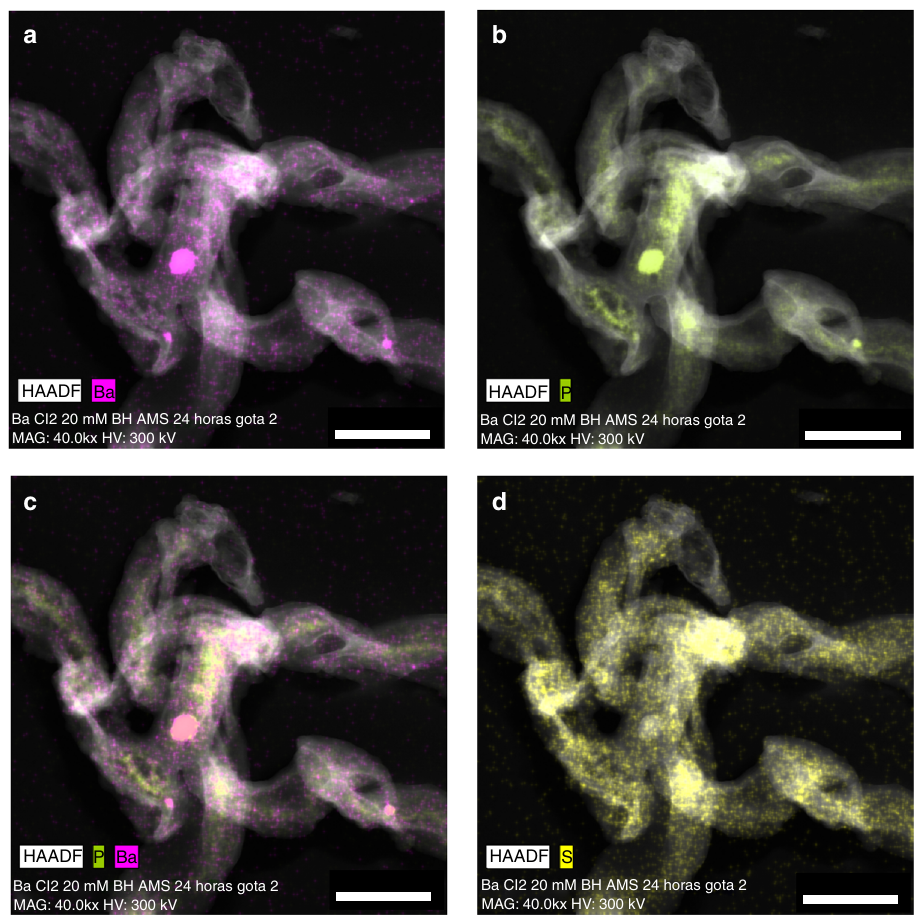
Fig. 3 HRTEM EDX maps of Ba, P, and S in bacterial cells. a , b High-angle annular dark fi eld (HAADF) STEM images and corresponding EDX maps showing the distribution of Ba and P respectively in bacterial bio fi lms of I . loihiensis MAH1 after 48 h of incubation in SSW2 medium. c Combined map of Ba and P showing the similar distribution of these elements . d Map of S showing the scattered distribution of this element within bacterial cells. Scale bar